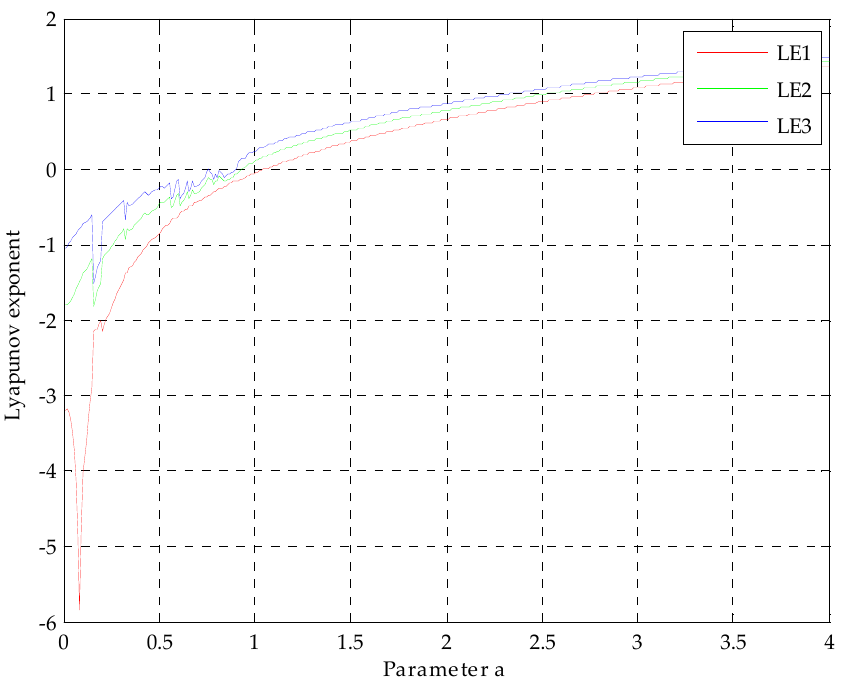
Figure 10. Exponential Lyapunov spectrum of system (3).